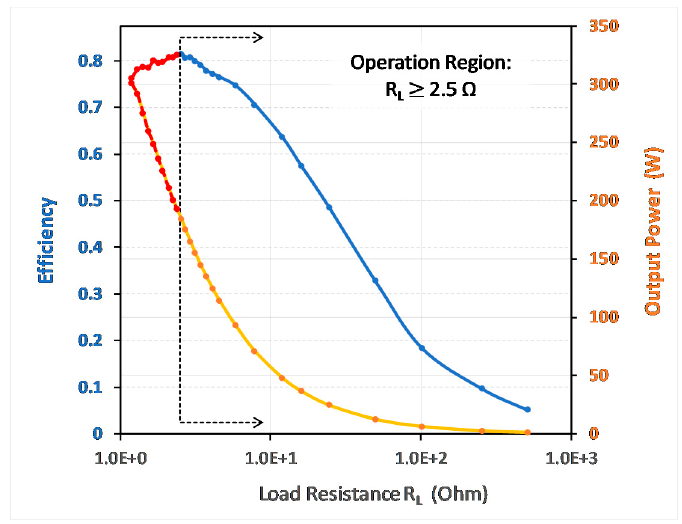
Figure 12. Experimental results of the output power and base overall DC efficiency as a function of R L (in logarithmic scale).